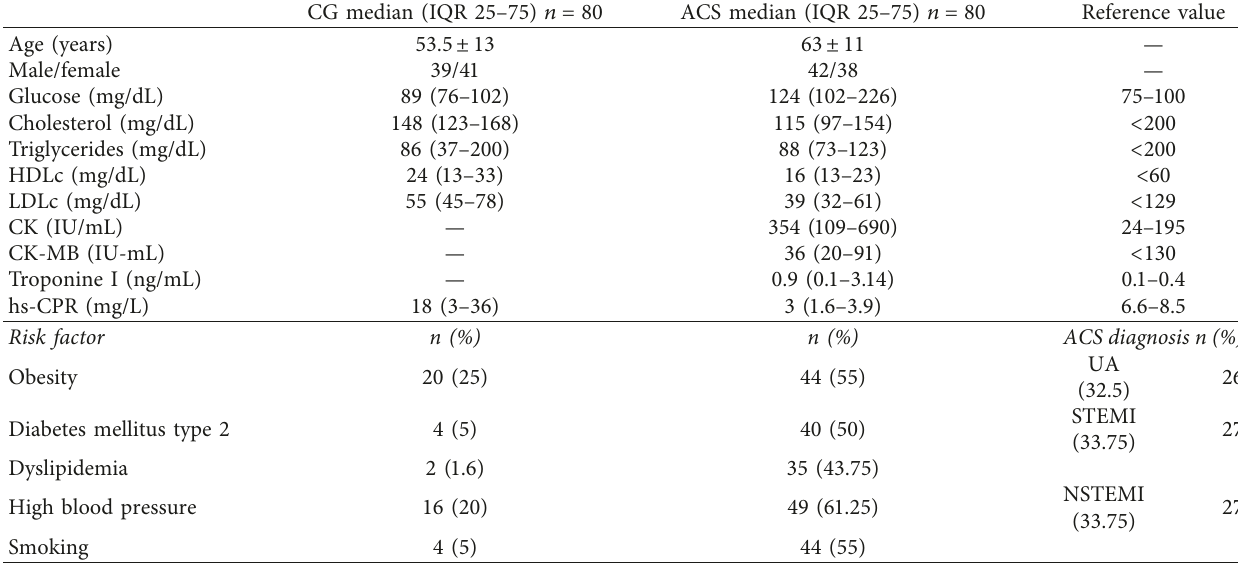
Table 1: Demographic and clinical data of the CG and patients with ACS.